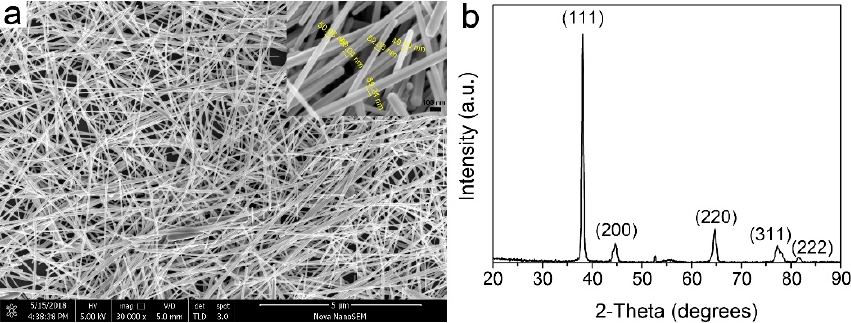
Figure 2. ( a ) SEM images of silver nanowires after being purified and ( b ) XRD spectrum of the synthesized silver nanowires.